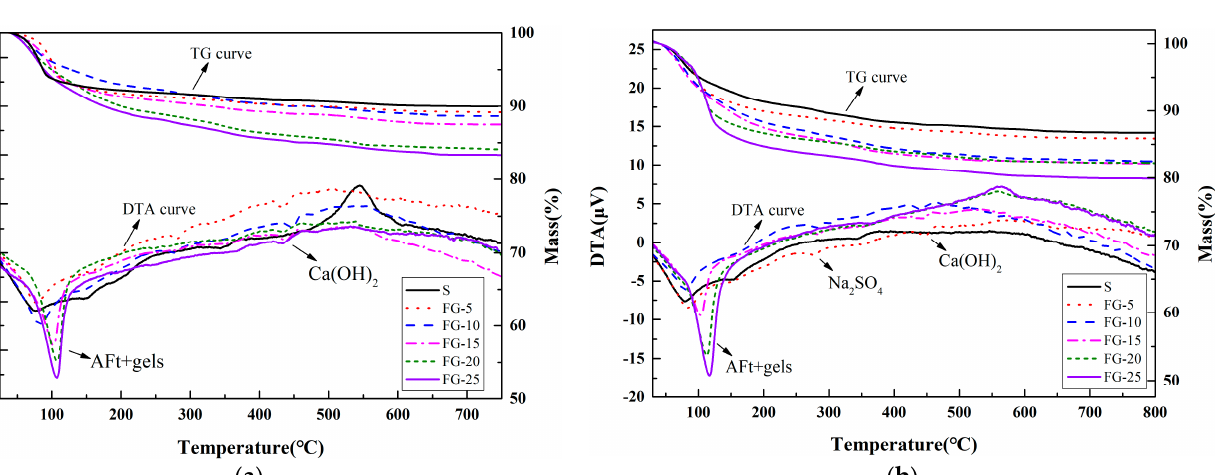
Figure 9. XRD patterns of cement paste with different FGDG content: ( a ) 3 days; ( b ) 28 days.